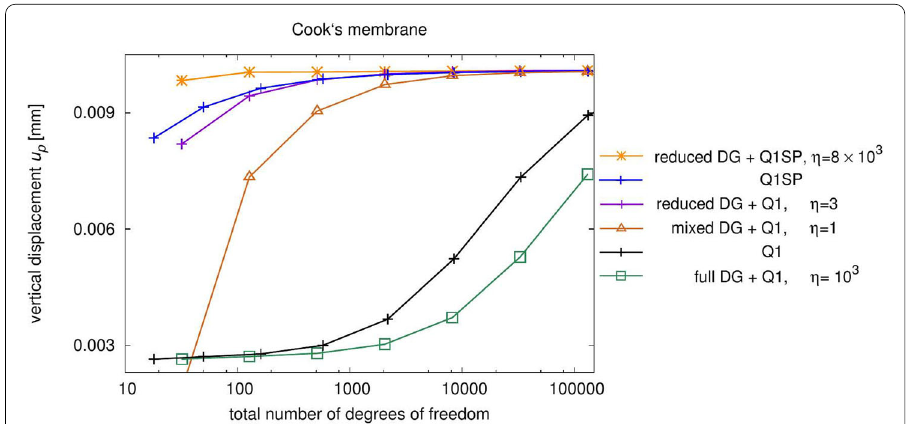
Fig. 5 Vertical displacement of the point P as a function of the total number of degrees of freedom for Q1, Q1SP, DG and their